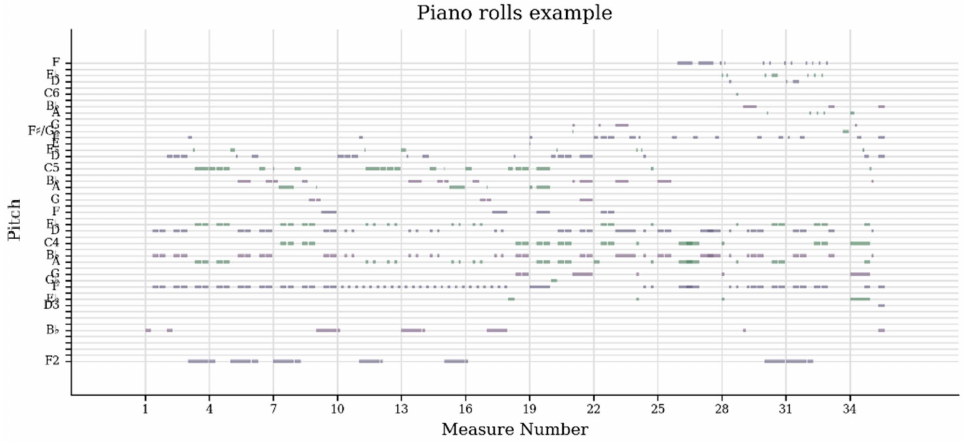
Figure 10. This is an example of a piano roll.